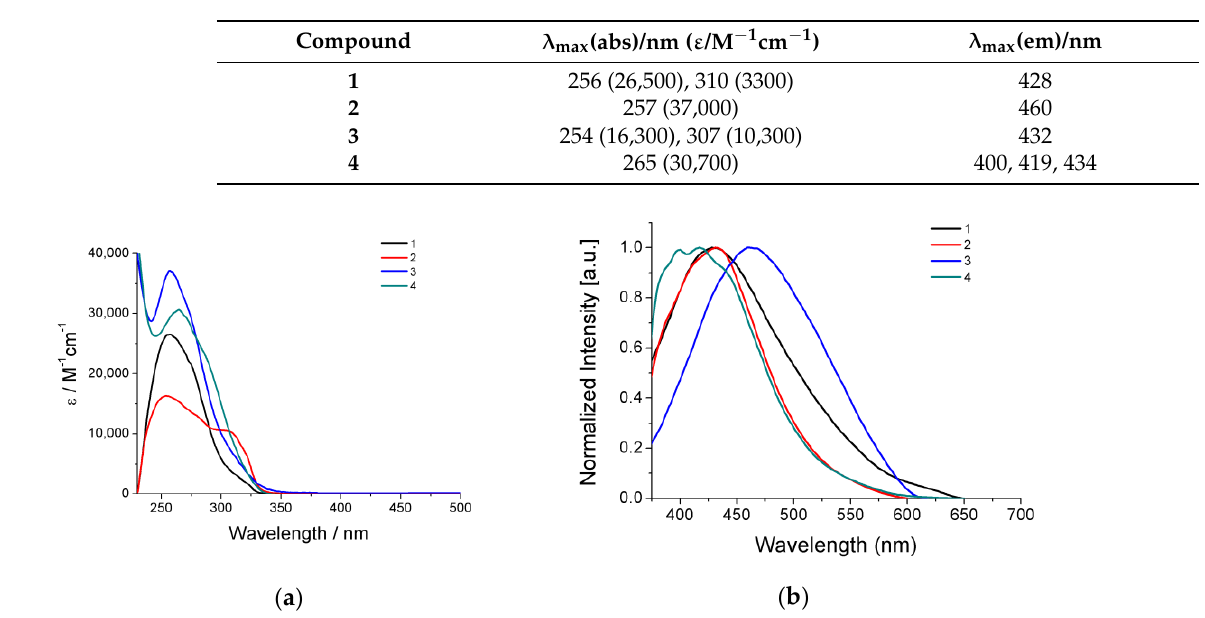
Table 2. Photophysical characteristics of compounds 1 – 4 : absorption band maxima λ max (abs) (in nm) and molar absorption coefficients ε (M − 1 cm − 1 ) in CH 2 Cl 2 solutions (~5 × 10 − 5 M), and emission